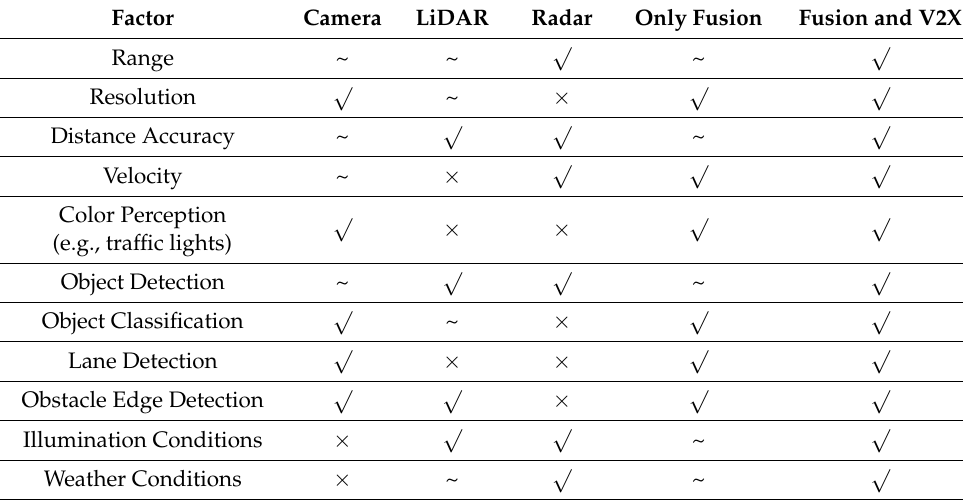
Table 1. A comparison of the commonly employed sensors in self-driving cars, only sensors fusion, √ and combined V2X. The “ ” symbol indicates that the sensor operates competently under the specific factor. The “~” indicates that the sensor performs reasonably well under the specific factor. The “ × ” indicates that the sensor does not operate well under specific factors relative to the other sensors. Factor Camera LiDAR Only Fusion Range Resolution Distance Accuracy Color Perception (e.g., traffic